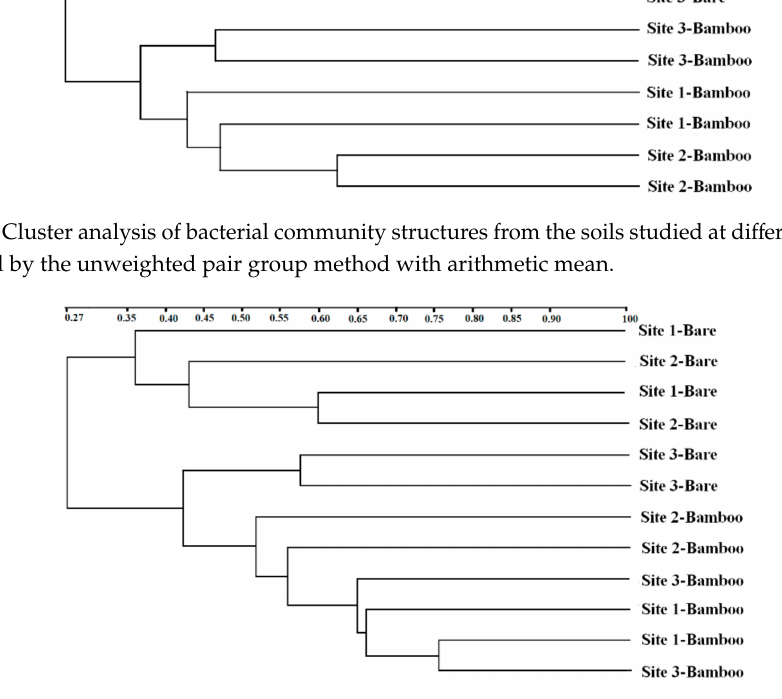
Figure 6. Cluster analysis of fungal community structure from the soils studied at di ff erent locations measured by the unweighted pair group method with arithmetic